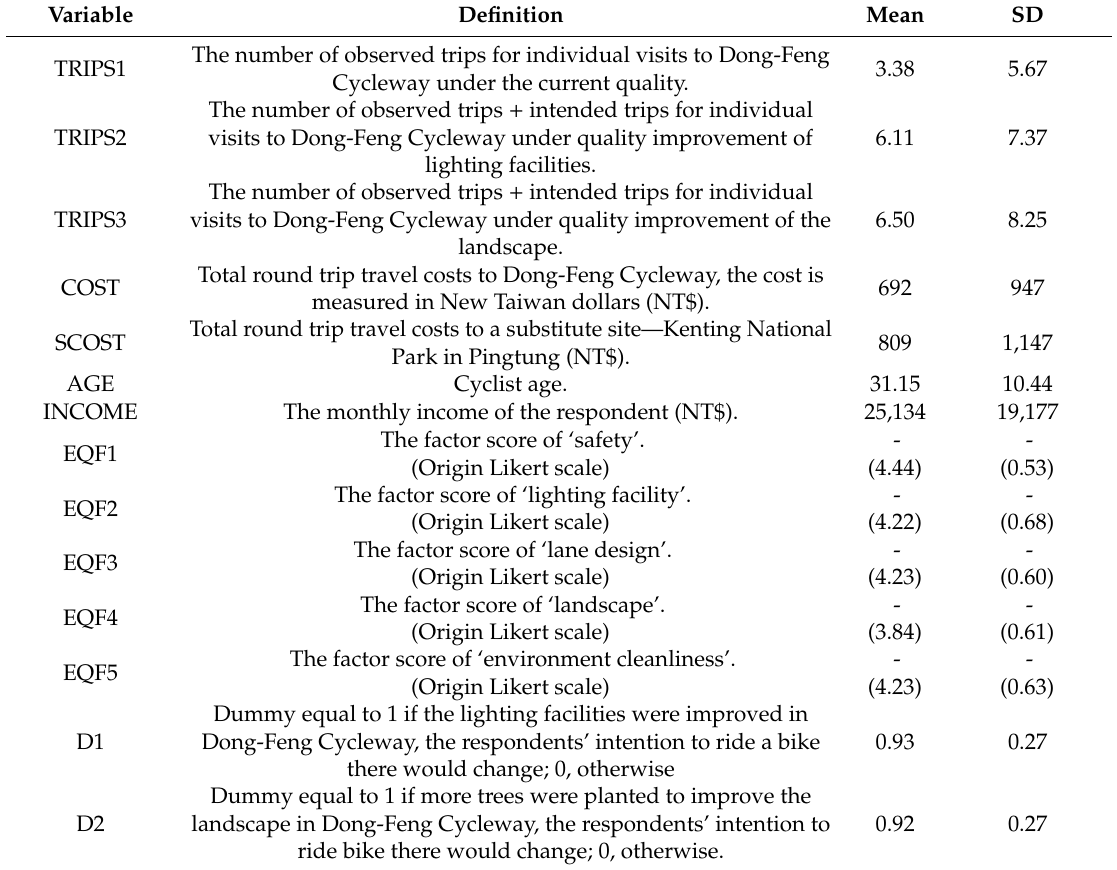
Table 1. Definition of the variables and descriptive